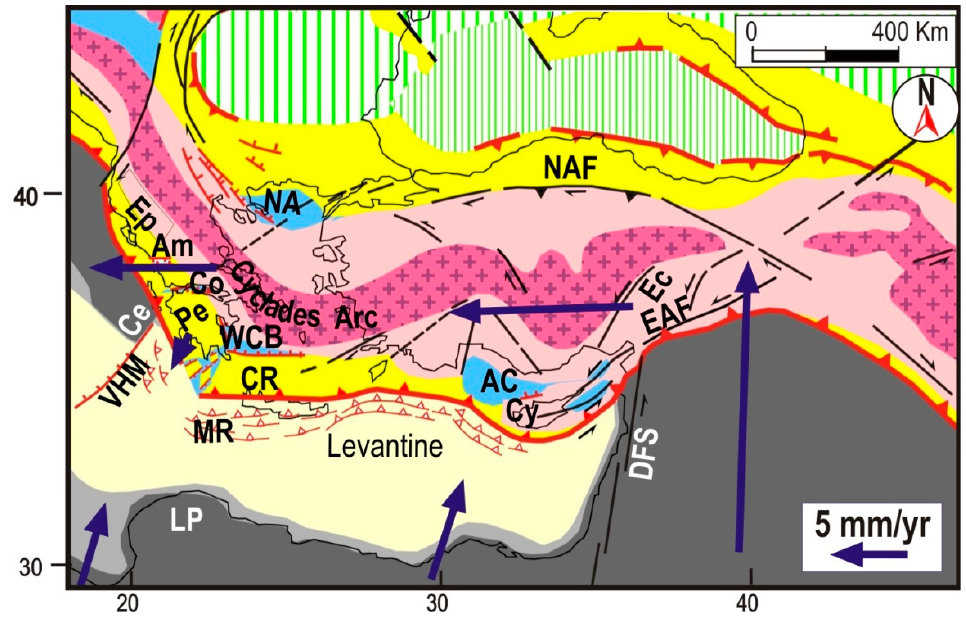
Figure 8. Middle Pliocene tectonic setting. AC—Antalia–Cilicia basin; Am—Ambracique trough; Ce—Cephalonia fault; Co—Corinth trough; CR—Crete–Rhodes (eastern Hellenic arc); Cy—Cyprus; EAF—East Anatolian fault system; Ep—Epirus; LP—Libyan promontory; MR—Mediterranean ridge; NA—North Aegean trough; Pe—Peloponnesus; WCB—western Cretan basin; VHM—Victor Hensen-Medina fault. Symbols colors and other abbreviations as in Figure 5 and Figure 7.